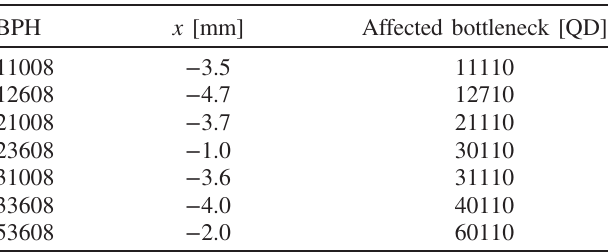
TABLE VII. Unfavorable matching targets of the reference orbit.